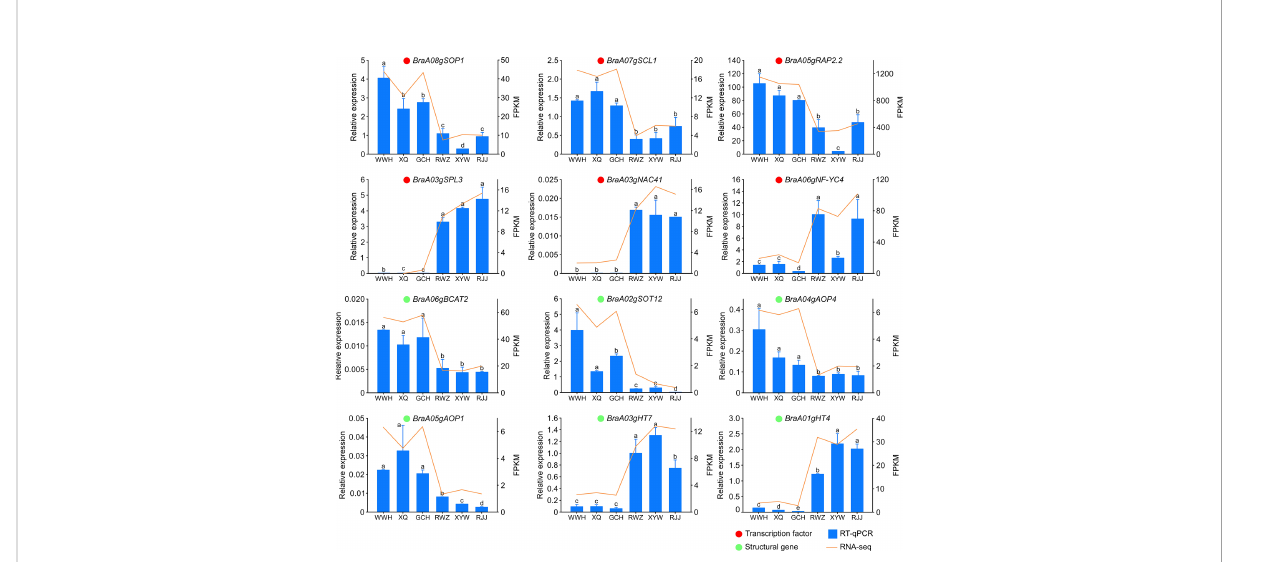
FIGURE 6 qRT- PCR veri fi cation of expression levels of key genes identi fi ed by RNA sequencing. The relative expression levels analyzed by qRT-PCR and calculated by 2 - △ Ct and bars with different lowercase letters are signi fi cantly different (P ≤ 0.05). The red circle represents transcription factors, and the green circle represents structural